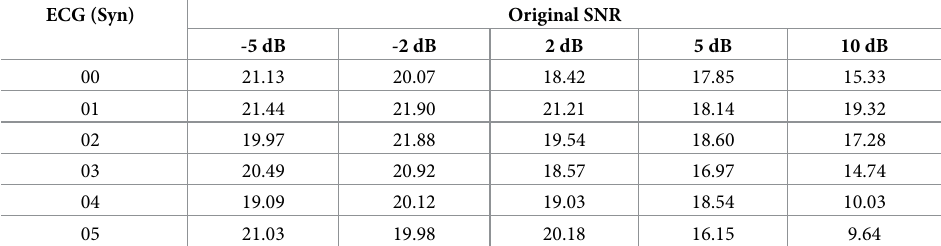
Table 3. SNR improvement from eliminating BW for synthetic ECGs.